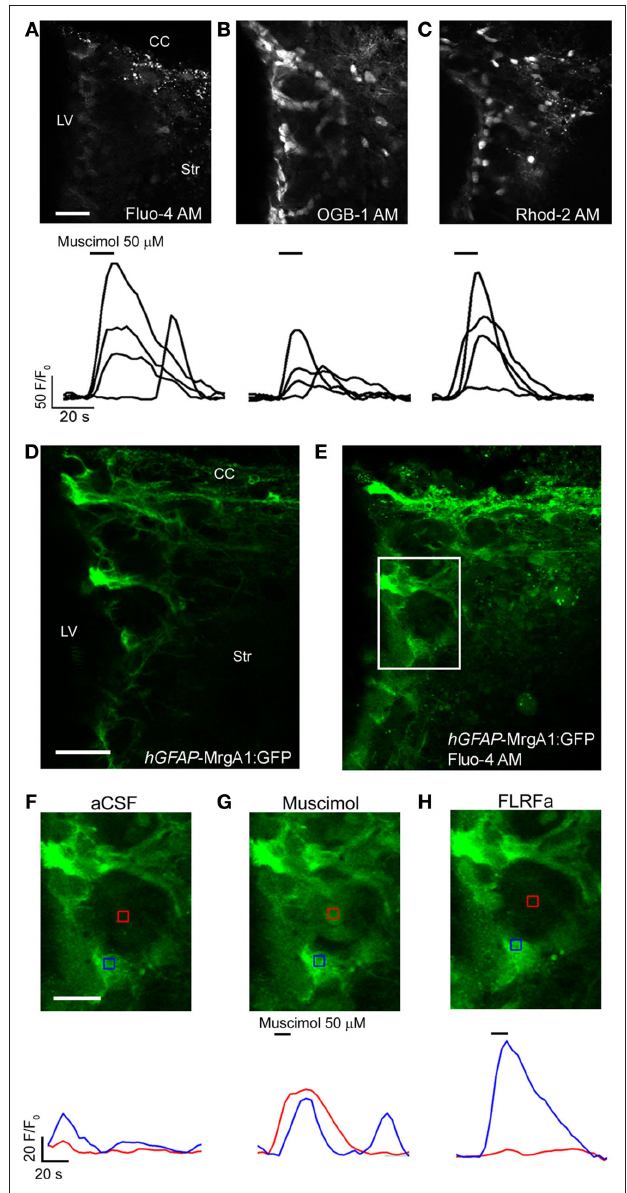
Figure 6 | Calcium imaging with different dyes and in transgenic mice. (A–C) Confocal images displaying SVZ cells loaded with Fluo-4 AM (A) , Oregon Green BAPTA-1 AM (OGB-1 AM) (B) , Rhod-2 AM (C) with corresponding muscimol-induced calcium responses under each image. (D, e) Confocal images of SVZ cells before (D) and after (e) Fluo-4 AM loading in a sagittal section from a hGFAP -MrgA1:GFP mouse. (F–H) Zoomed images from the white box shown in (D) and (e) , before (F) and during muscimol (g) or FLRFa (H) application. CC, corpus callosum; LV, lateral ventricle;